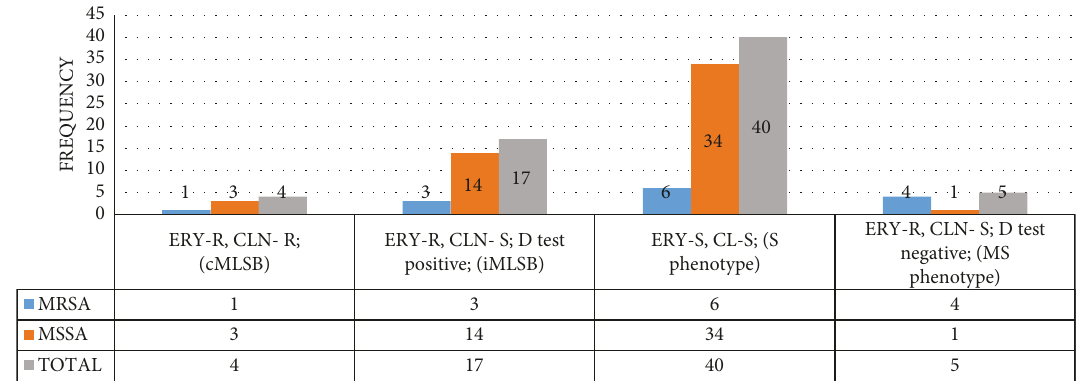
Figure 2: Comparison of the MLSB resistance phenotype between MRSA and MSSA among patients attending University of Gondar Comprehensive Specialized Hospital, Ethiopia,